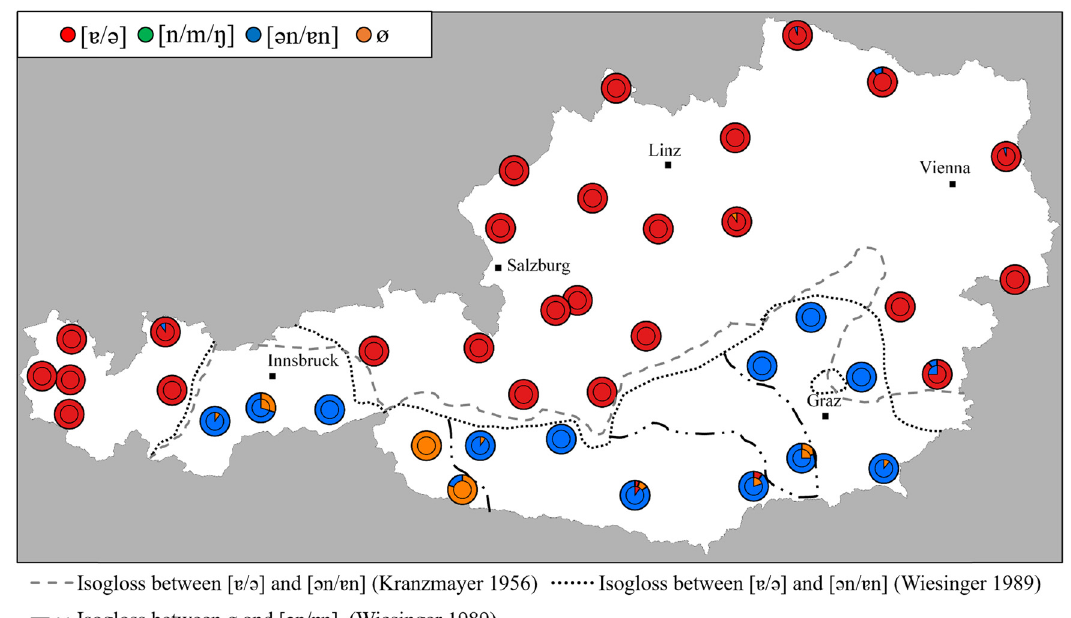
Figure 3: ( en ) following nasals ( inner circles = percentage of variants realised by older speakers; outer circles = percentage of variants realised by younger speakers )